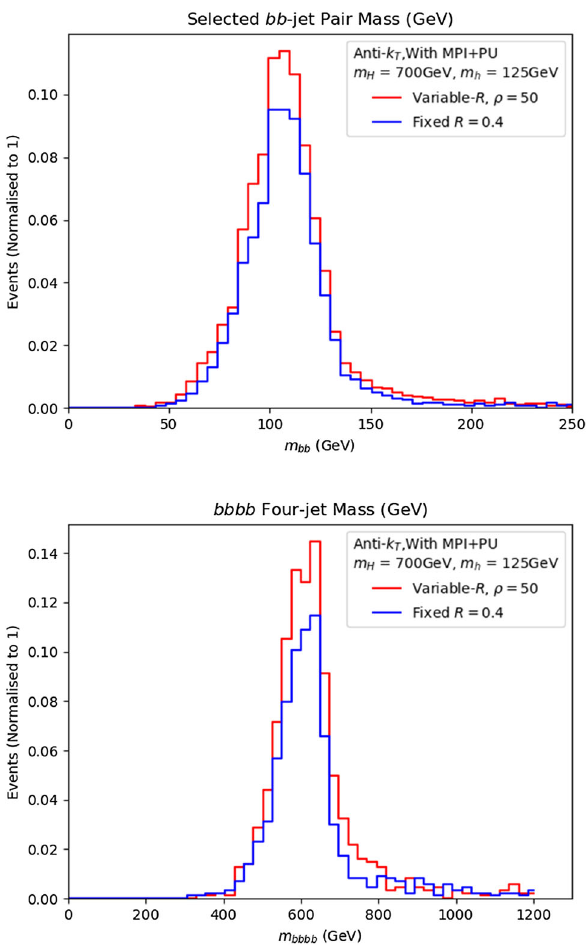
Fig. 15 Upper panel: the b -dijet invariant masses for BP1, using variable- R and fixed- R clustering, when considering the effect of PU and MPIs. Lower panel: the same for the 4 b -jet invariant mass